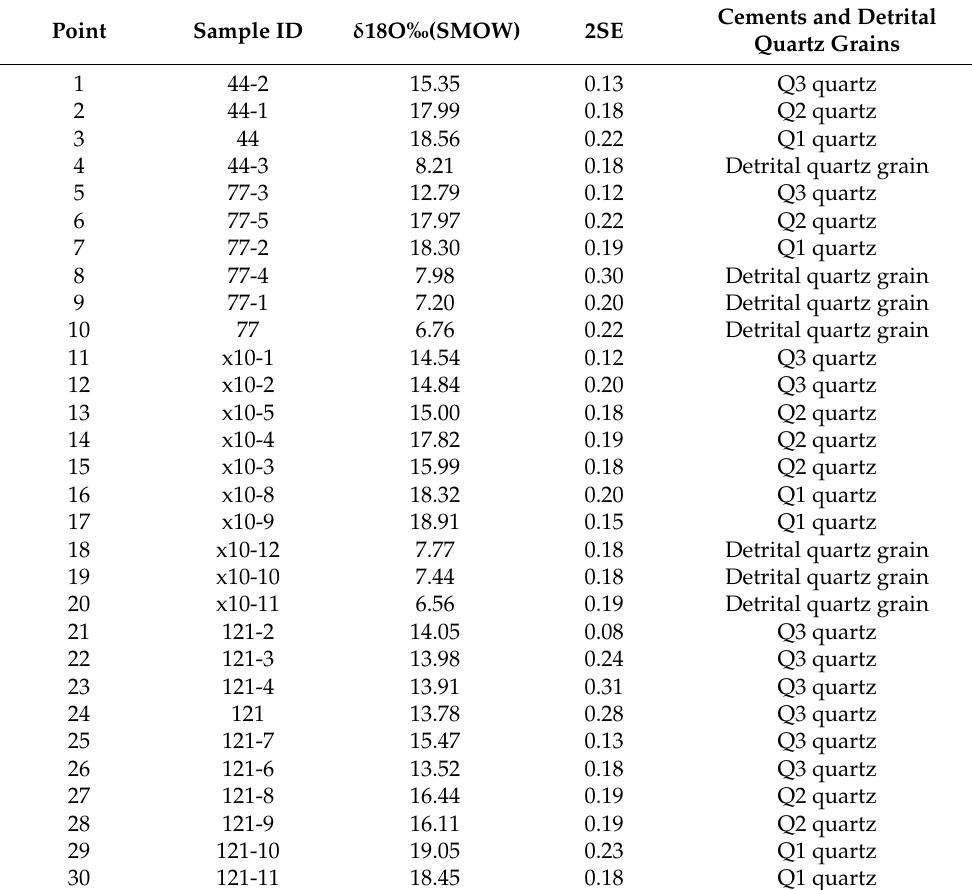
Figure 6. Histograms of the oxygen isotope ratios of the quartz in the Xu2 sandstones measured in situ, including the cements and detrital quartz grains.